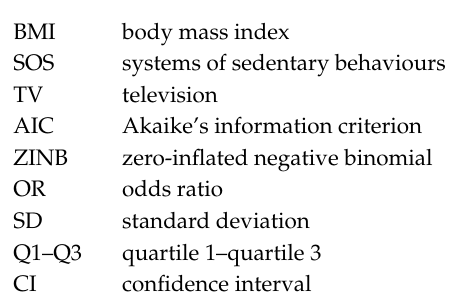
Table S1: Test-retest reliability of home environmental factors and domain-specific sedentary behaviors, Data S1: Raw